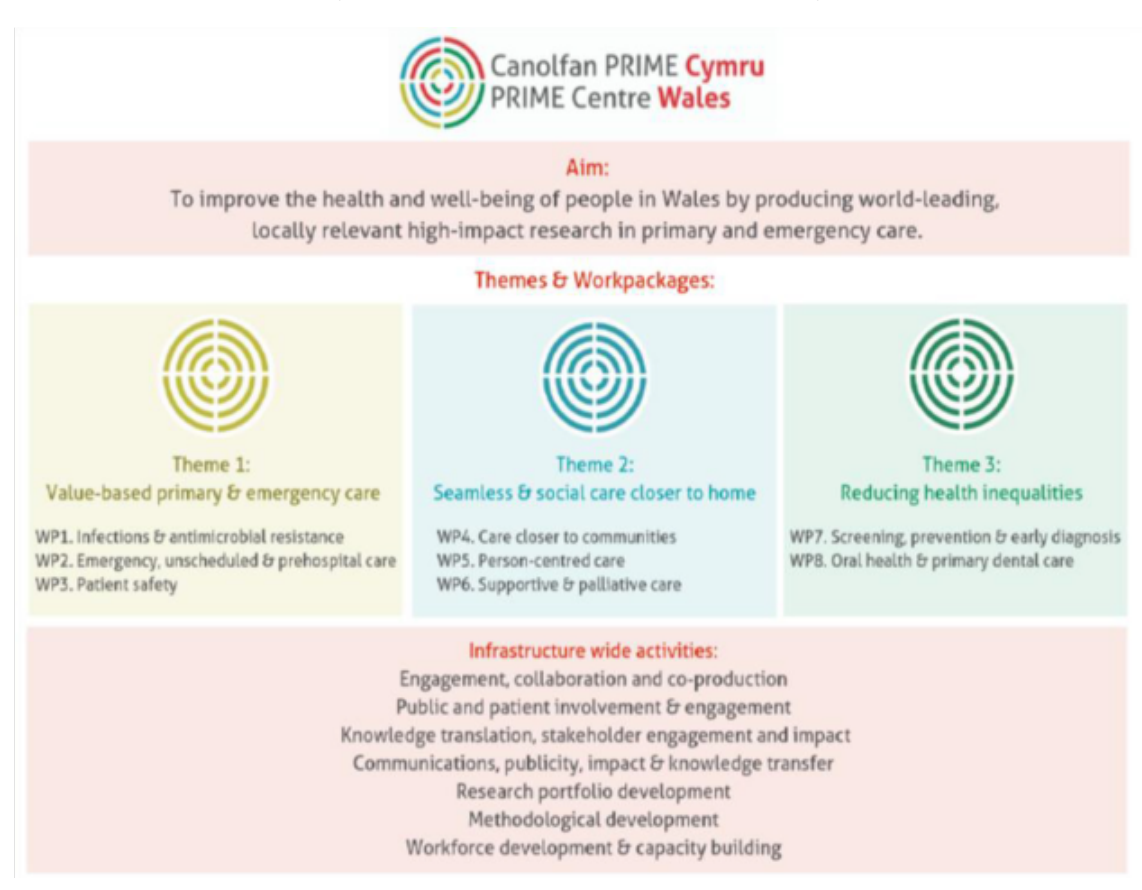
Figure 1: PRIME’s aim, themes and work